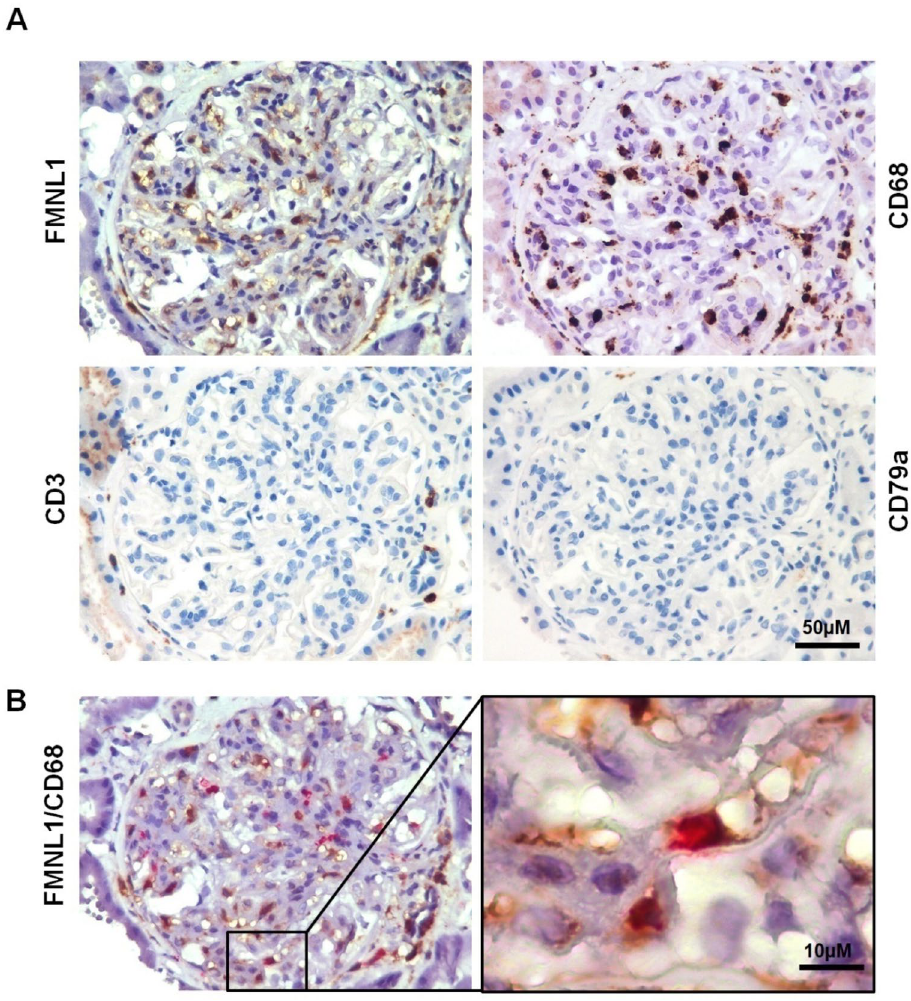
Figure 7. Characterization of FMNL1 expressing cells in renal biopsies. ( A ) Serial sections of PLA2R1 negative MN were immunostained with FMNL1, CD68 (monocyte/macrophage marker), CD3 (lymphocyte T marker) and CD79a (lymphocyte B marker) antibodies. Glomerular circulating cells expressing FMNL1 were CD68 positive and CD3 and CD79a negative. Original magnification 320x, scale bar: 50 µm. ( B) PLA2R1 negative MN section was double immunostained with FMNL1 and CD68 Representative micrographs of glomerular circulating cells positively stained with FMNL1 (brown) and CD68 (red). Boxed area is enlarged in the right side of the figure. Magnification 320x, scale bar: 50 µm; Boxed area magnification 1600 x, scale bar:10